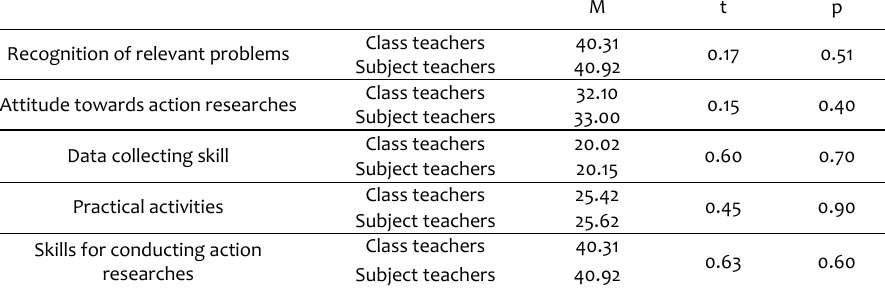
Table 3 : Teachers’ competences and attitudes towards conducting action researches considering their professional training